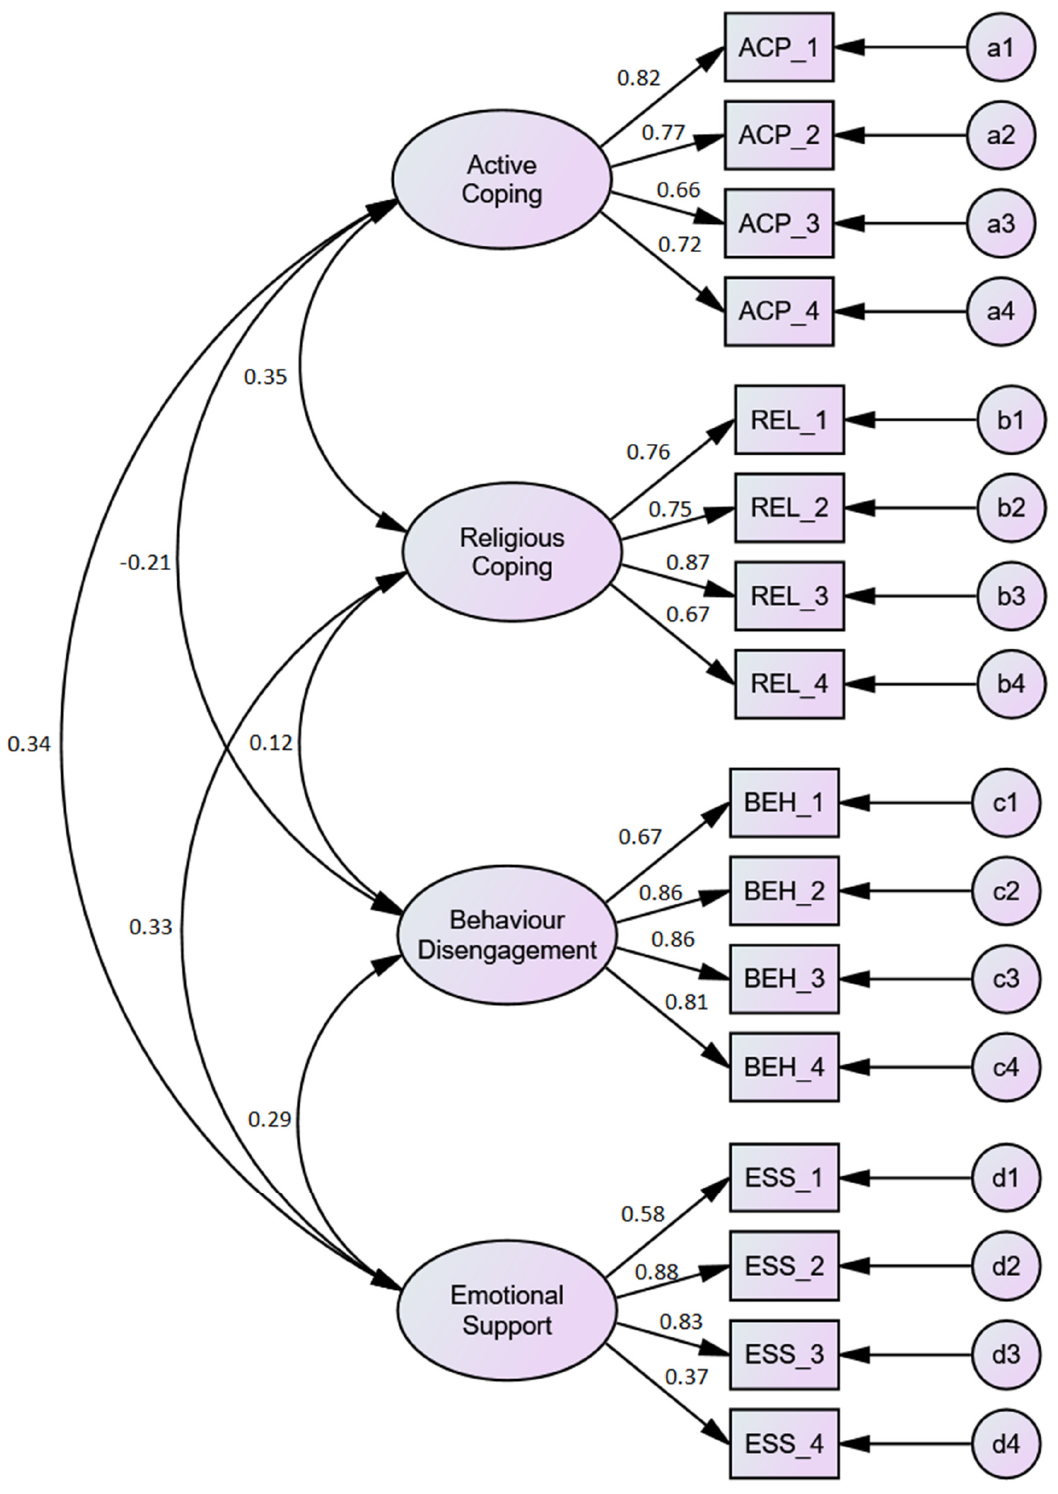
Figure 1. Multi-Factor First-Order CFA Model (Model